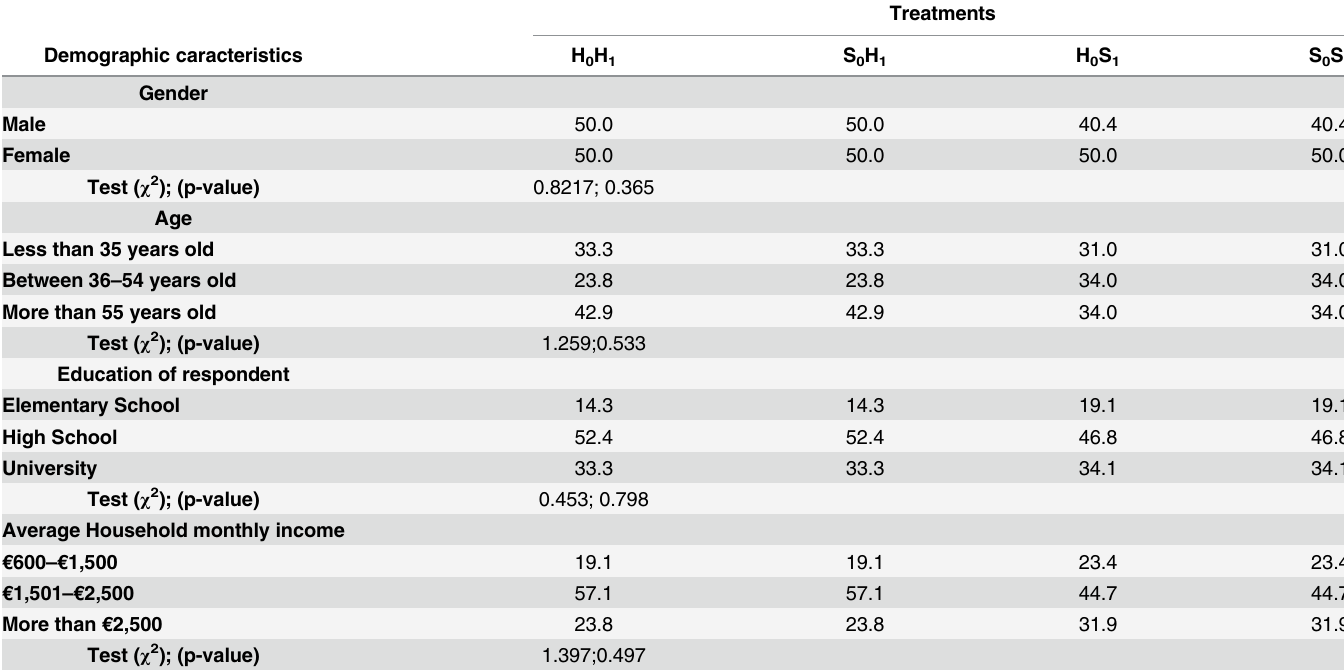
Table 2. Sample characteristics and demographic variables definition